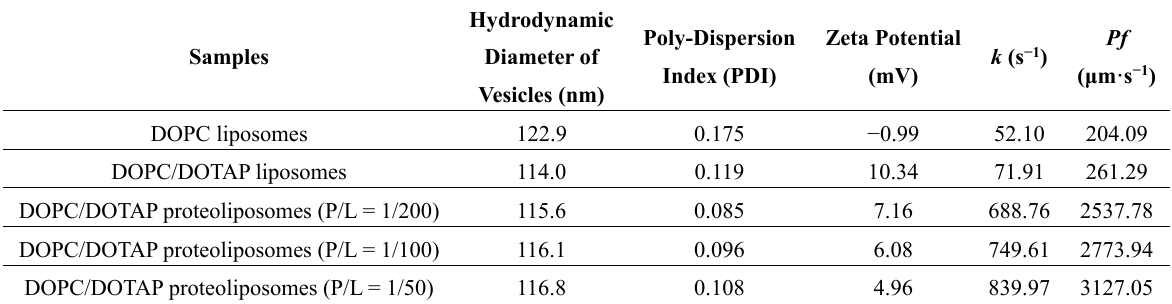
Table 1. Characterization of DOPC, DOPC/DOTAP liposomes, and proteoliposomes. Hydrodynamic Samples Diameter